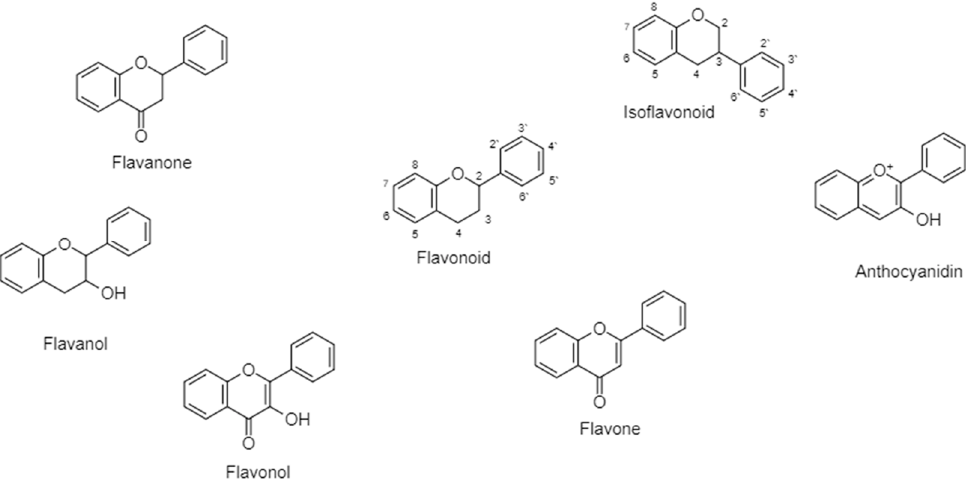
Figure 5. Cont. Figure 5.